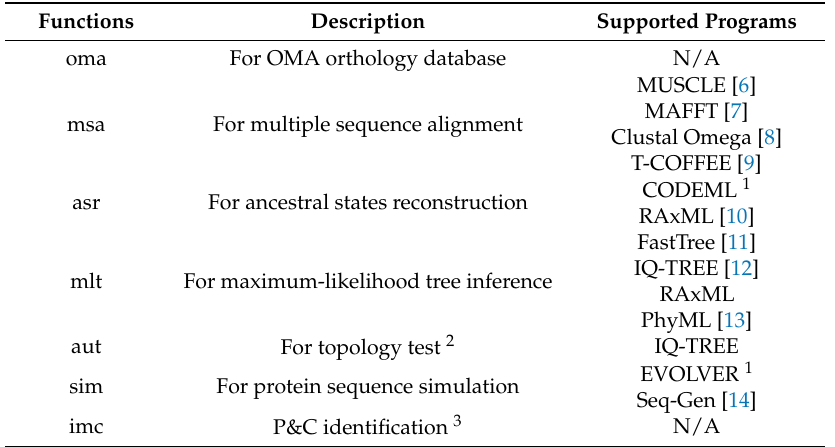
Table 1. Summary of functions and supported programs in ProtParCon